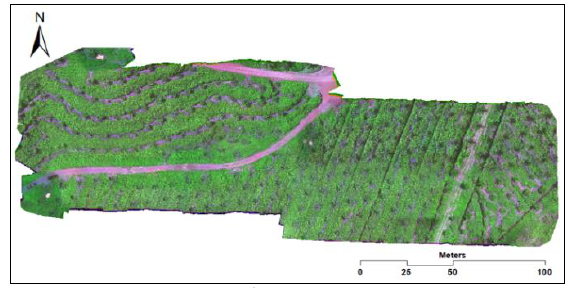
Figure 1. Study Area (MicaSense RedEdge in False Composite B, Red Edge, Red)